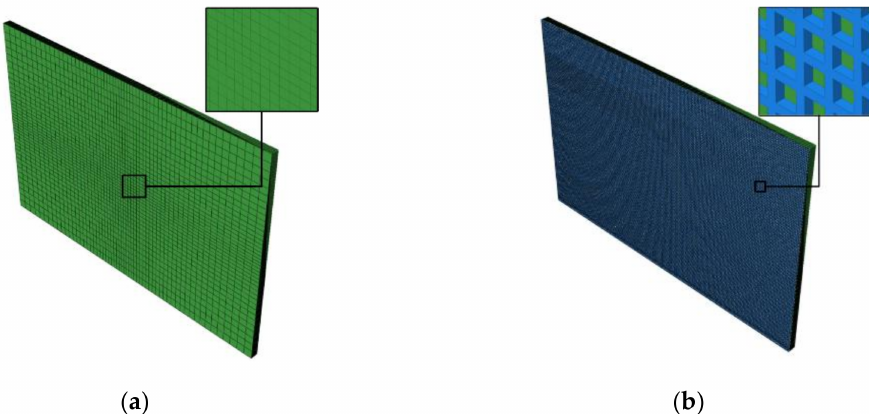
Figure 2. Appearance of finite element analysis (FEA) models. ( a ) The unprotected CFRP laminates (Group A); ( b ) The copper mesh protected CFRP laminates (Group B).